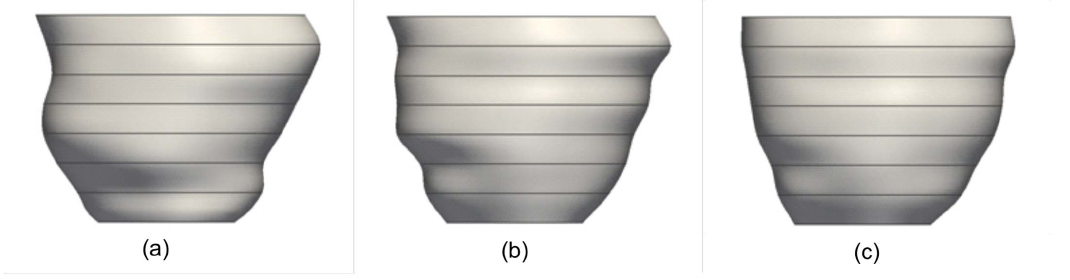
Figure 3. Shape restoration using dual resolution semi-rigid deformation. (a) original mesh with motion artifact, (b) intermediate mesh after optimization using n-ring =5, and (c) final mesh after optimization using n-ring =2.